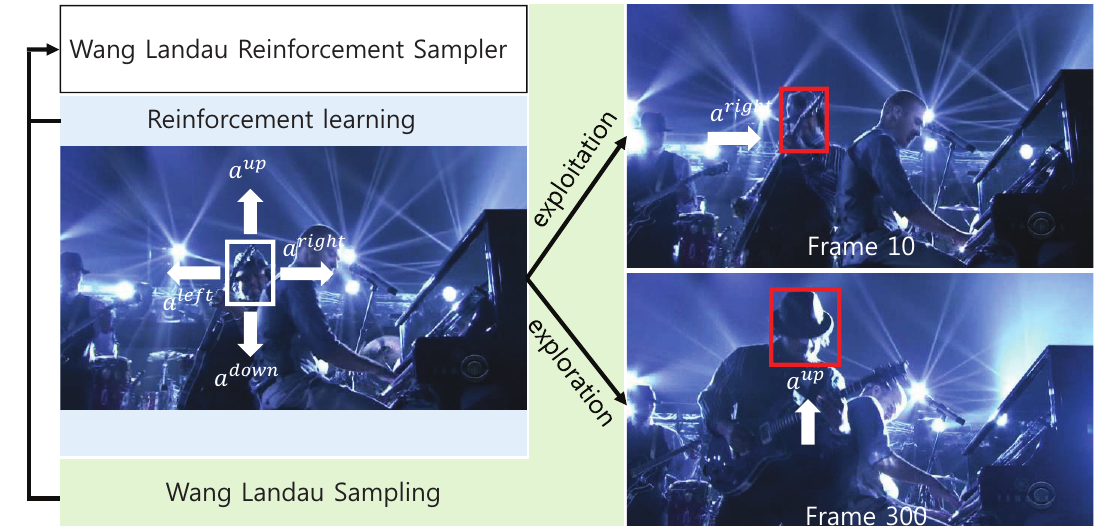
Figure 1. Basis of the proposed Wang–Landau reinforcement sampler. Reinforcement learning proposes one of the action choice (i.e., a left , a right , a up , and a down ) to move the target state. For example, if a right is selected by our visual tracker, we move the target state to the right. The proposed visual tracker combines this reinforcement learning with Wang–Landau sampling to balance between the exploitation and exploration degrees of the